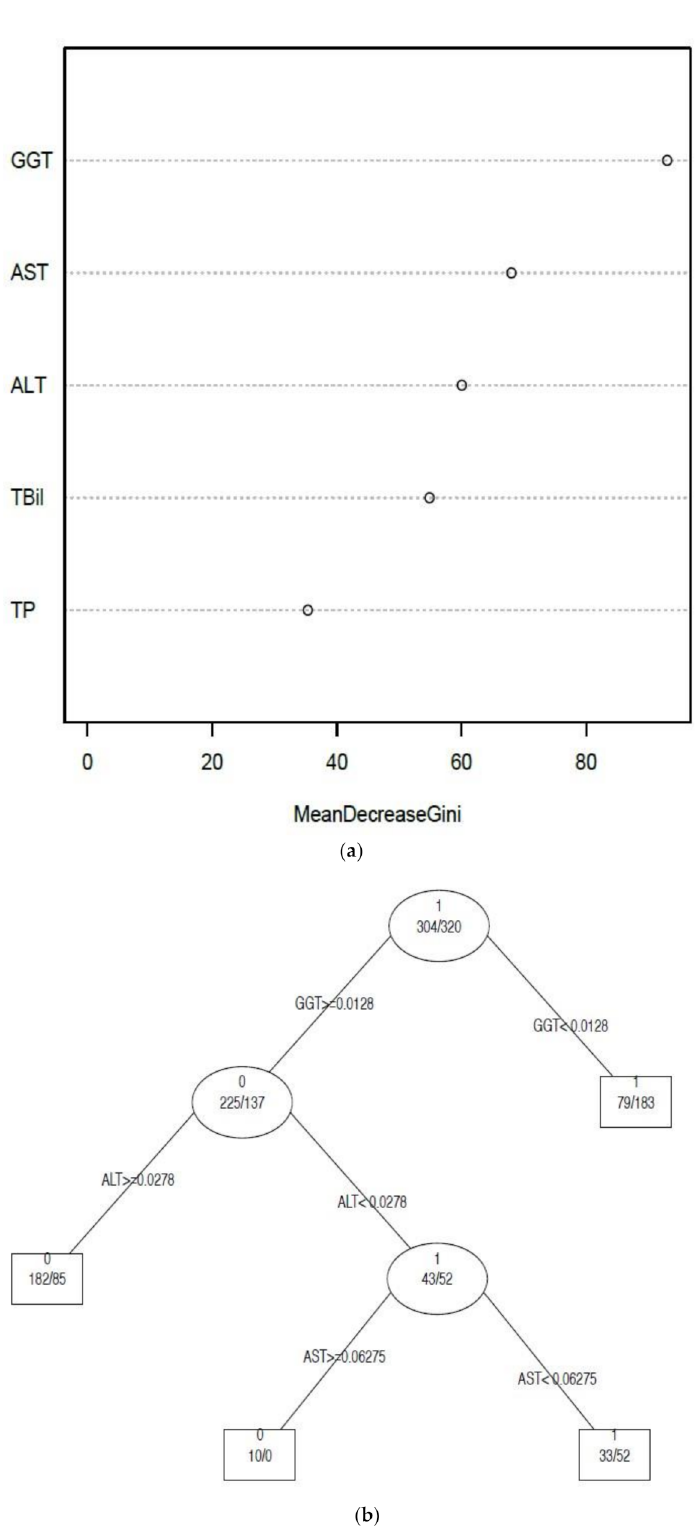
Figure 3. Recursive partitioning results from the modelling of EQA Liver Function Test (LFT) relative deviation results to predict the NATA Minor Class Condition reports. ( a ) Random Forest model predicting NATA Classes; ( b ) the same model as ( a ), but interrogated by a single decision tree. Features of the random forest modelling are presented in Table